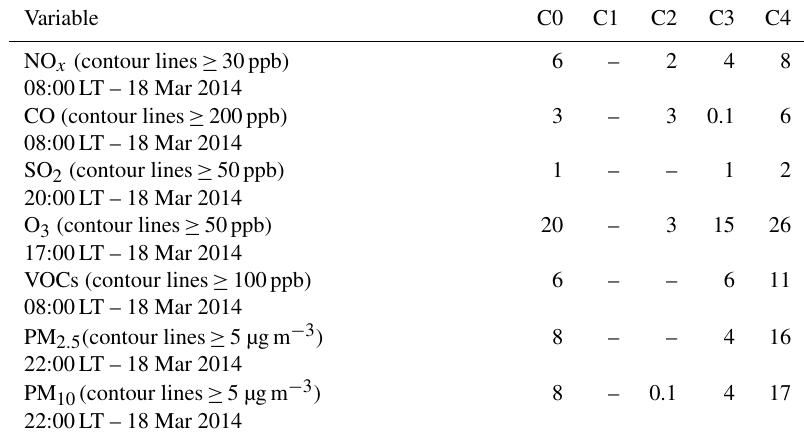
Table 9. Area (km 2 ) influenced by the pollution plume, represented as a function of Manaus urban area, for all simulated